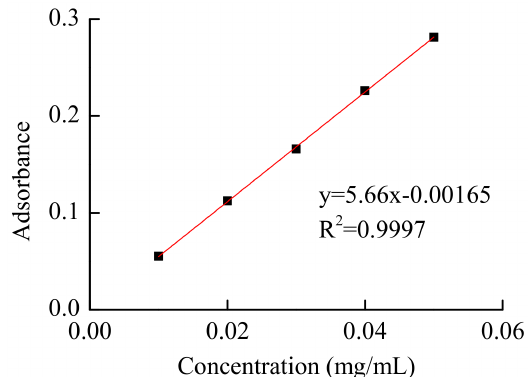
Figure 10. Standard curve of the concentration of total